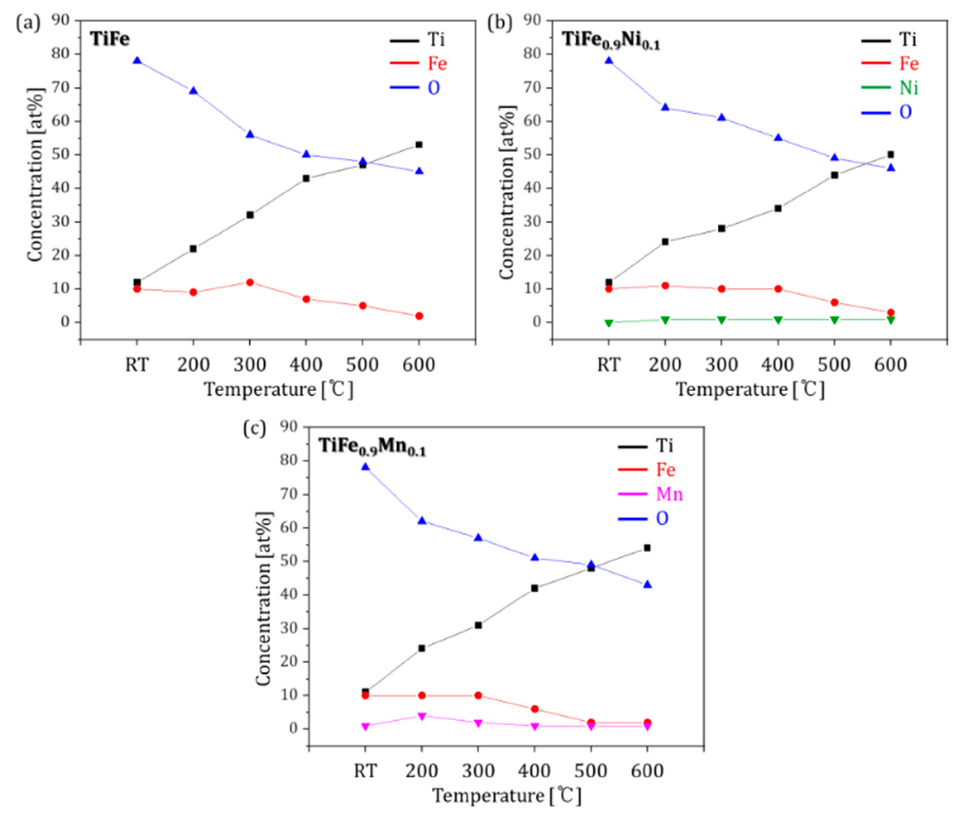
Figure 7. The composition evolution in the ( a ) TiFe, ( b ) TiFe 0.9 Ni 0.1 , and ( c ) TiFe 0.9 Mn 0.1 alloys during in situ heating X-ray photoelectron spectroscopy (XPS).